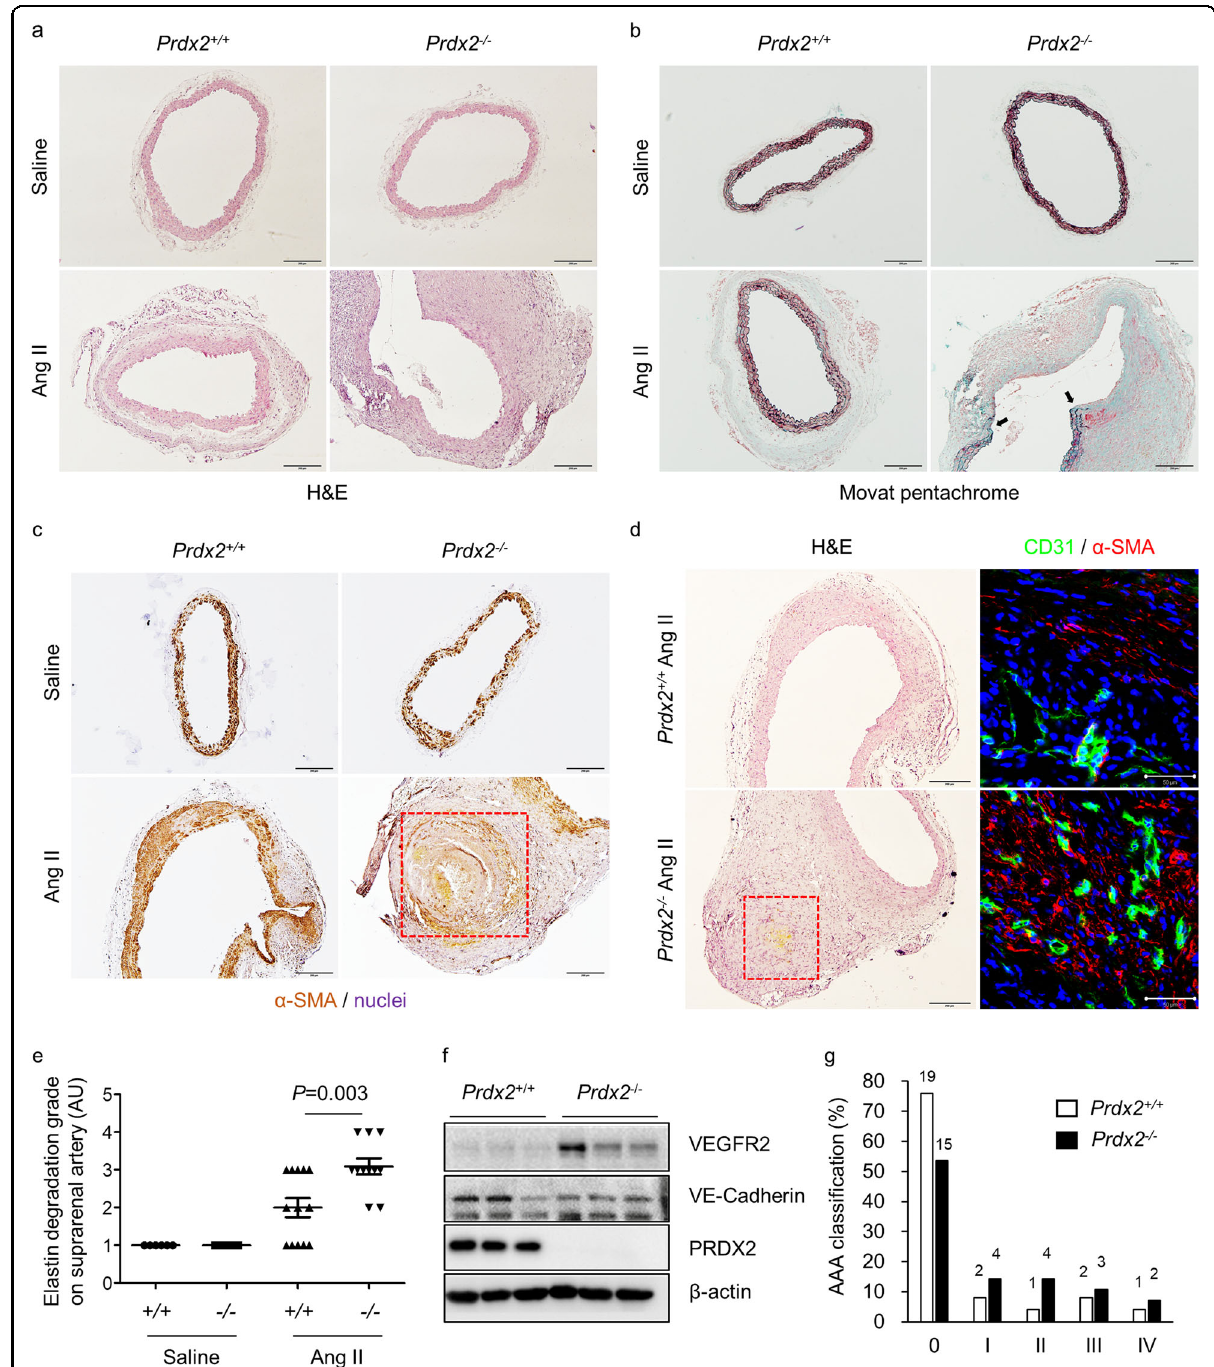
Fig. 4 Loss of PRDX2 accelerates the structural deterioration of aortas in mice with Ang II-induced AAA. a Representative H&E- and b Movat pentachrome-stained images of cross-sectioned abdominal aortas from Prdx2 + / + and Prdx2 − / − mice infused with saline or Ang II for 4 weeks. Scale bar, 200µm. c Representative immunostaining of α -SMA in cross-sectioned abdominal aortas. Nuclei were stained with hematoxylin. Scale bar, 200µm. The boxed area indicates the apoptotic death of VSMCs. d Representative images of H&E (left; scale bar, 200µm) staining and immunostaining of CD31 (green) and α -SMA (red) (right; scale bar, 50µm) in cross-sectioned abdominal aortas. Nuclei were stained with DAPI. The boxed area shows microhemorrhage in the aneurysmal lesion. e Extent of elastin degradation in the suprarenal artery (AU) based on Movat pentachrome-stained images of abdominal aortic cross-sections (saline groups, n = 5 – 6; Ang II groups, n = 11 – 13). Data are presented as the mean±SEM (two ‐ tailed Student ’ s t -test). f Immunoblotting analysis of VE-cadherin, VEGFR2, and PRDX2 in aneurysmal aortas from Prdx2 + / + and Prdx2 − / − mice infused with Ang II for 4 weeks. β -actin was used as a loading control. g AAA classi fi cation (%) of Prdx2 + / + ( n = 25) and Prdx2 − / − ( n = 28) mice infused with Ang II for 4 weeks according to a scale from 0 (no aneurysm) to 4 (multiple aneurysms with